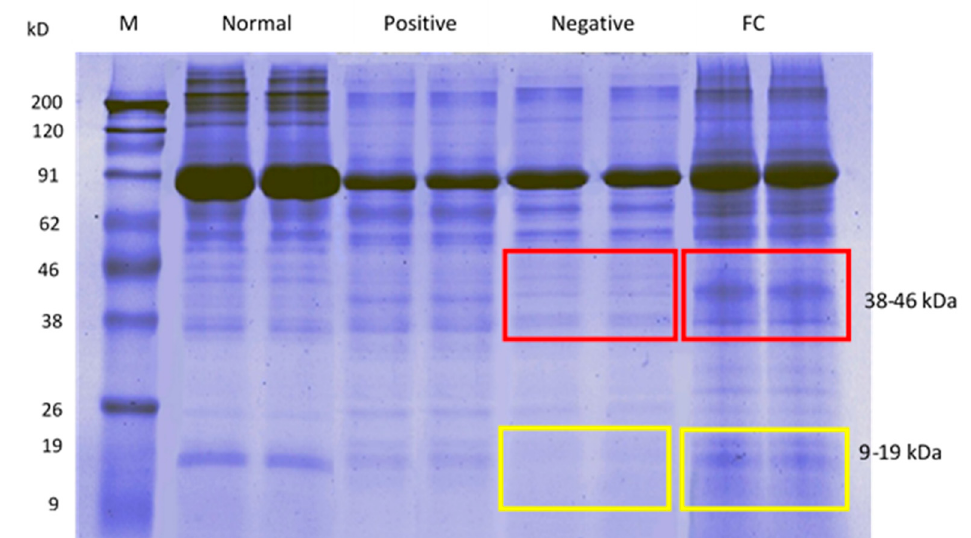
Figure 6. Sperm protein bands from four groups using SDS-PAGE electrophoresis. Column M is a molecular weight marker; normal: Sperm protein from normal group; positive: Diabetic treated with metformin; negative: Diabetic without treatment, and FC: Diabetic treated with F. carica.